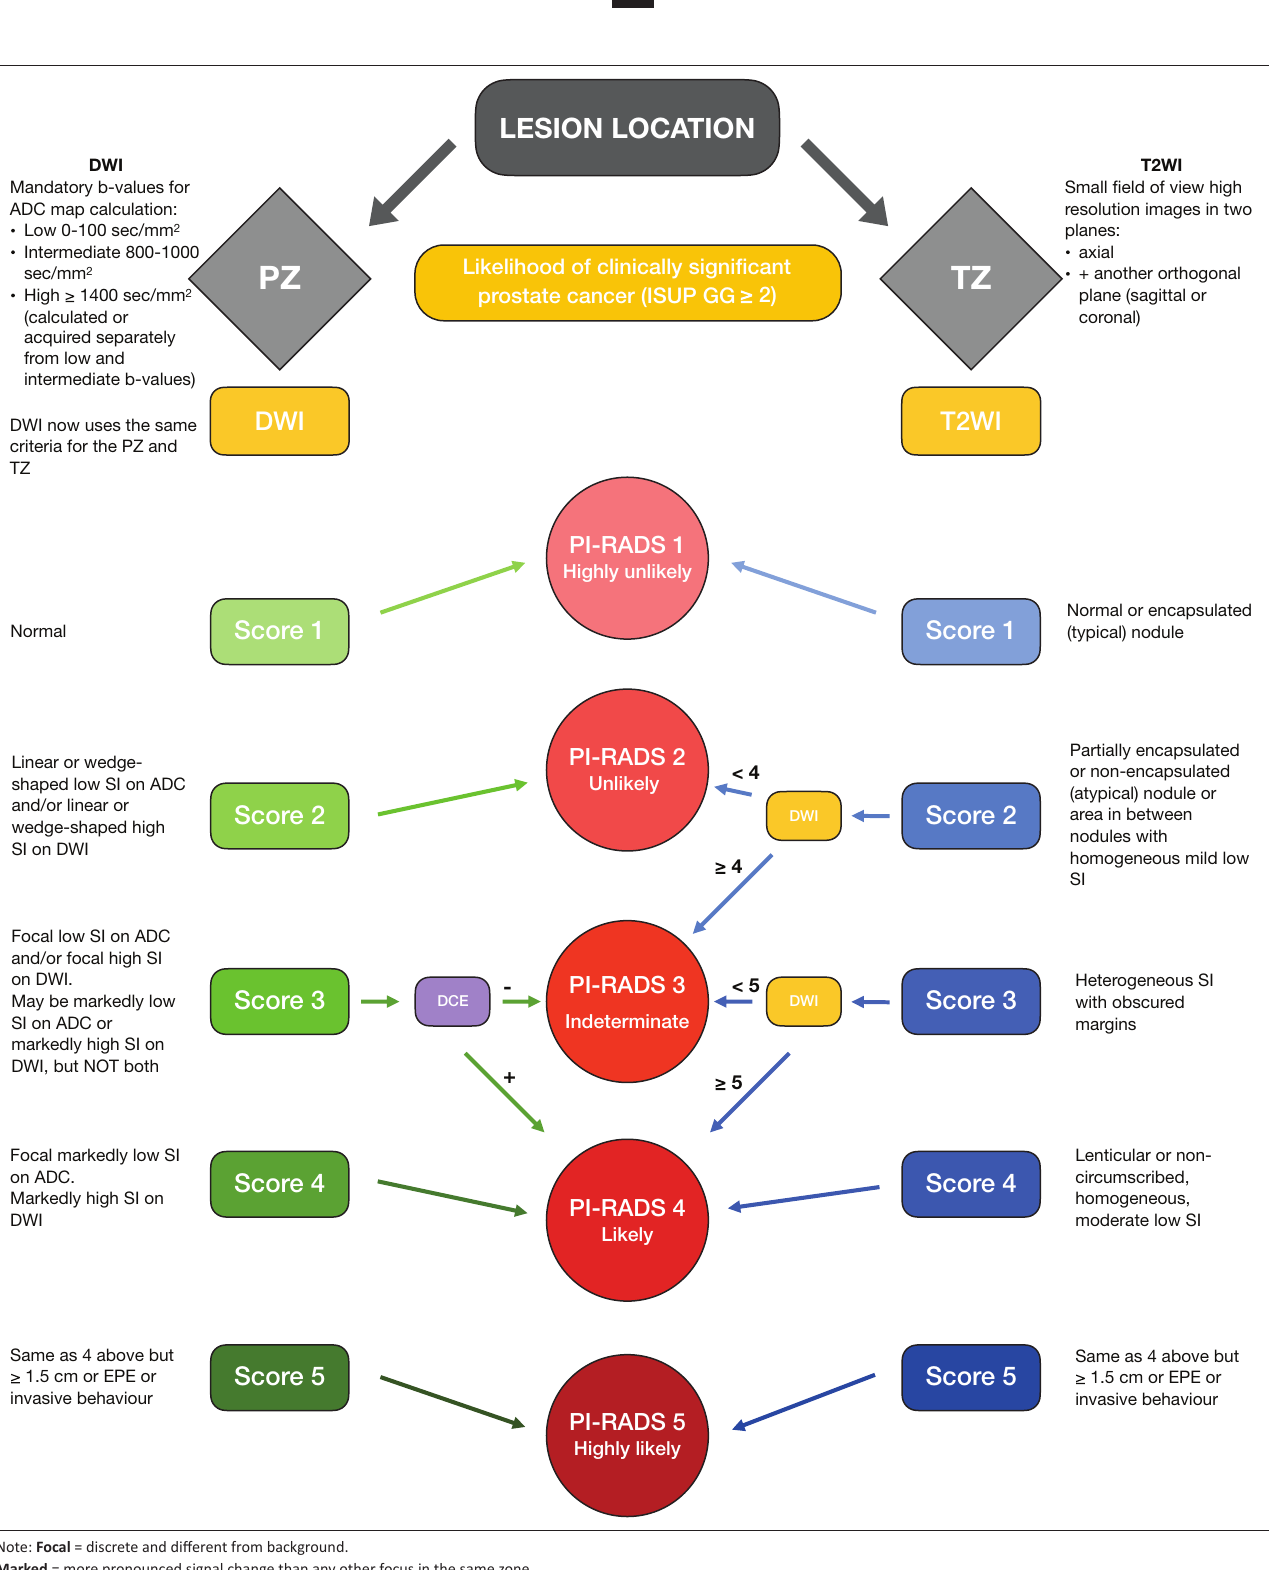
FIGURE 11: Flow diagram outlining the interplay of findings on relevant multiparametric prostate magnetic resonance imaging sequences for scoring of prostatic lesions in the peripheral zone and transition zone regions.